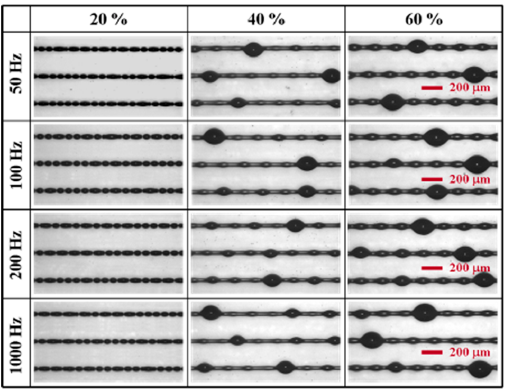
Figure 6. Microscopic images of inkjet-printed lines on the S 50 substrate for various printing frequencies and droplet overlaps at room temperature.